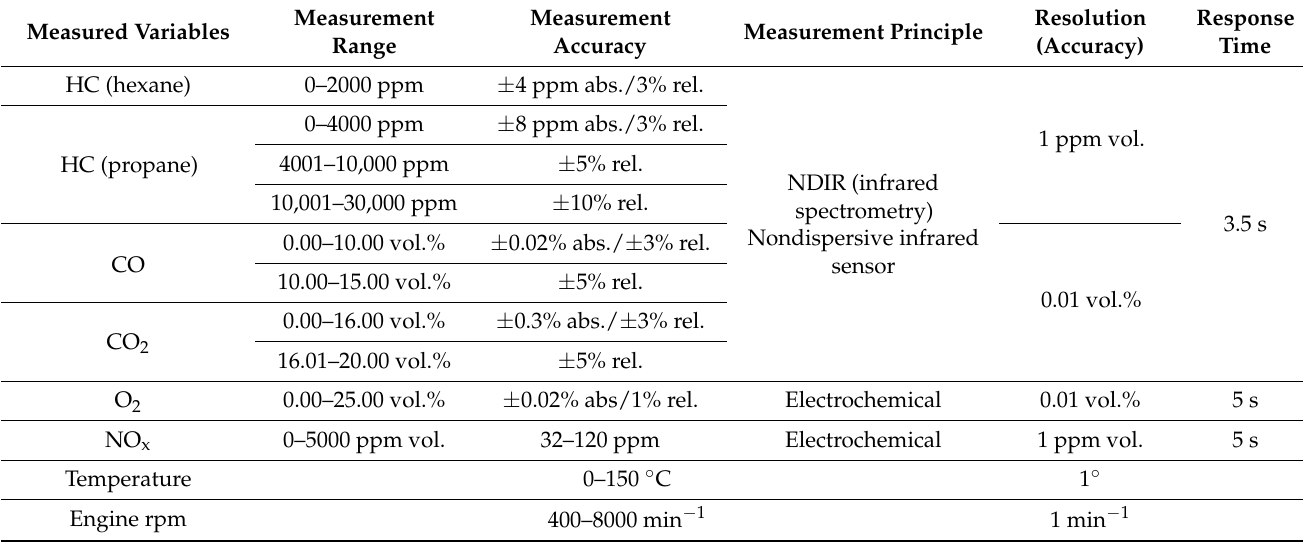
Table 2. Specifications of the MAHA MET 6.3 measuring